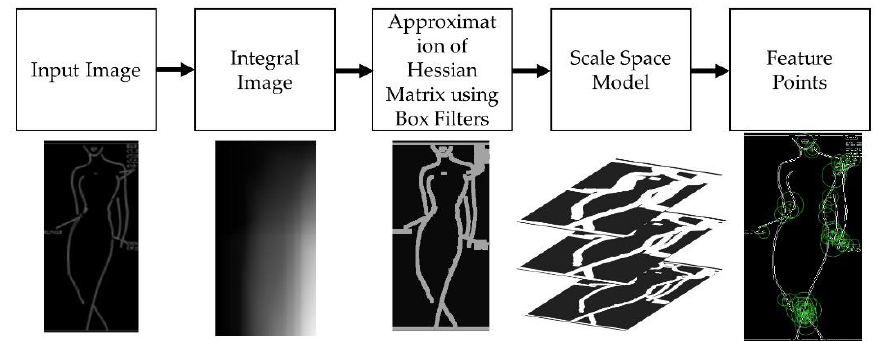
Figure 5. Block diagram of the SURF feature point detection. The SURF feature point extracting procedure consists of the generation of an integral image, the approximation of Hessian determi- nant, and performing non-maximal suppression [36].